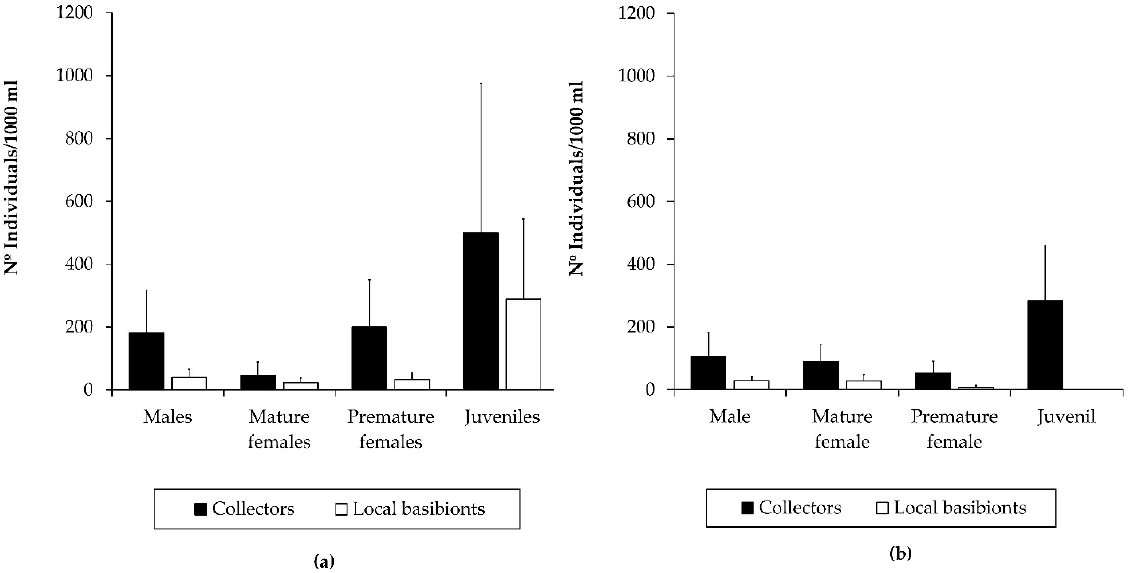
Figure 4. Population structure of Caprella scaura colonizing collectors versus inhabiting local basibionts in Puerto América marina in: ( a ) the one-month study period ( b ) and the three-months study period .